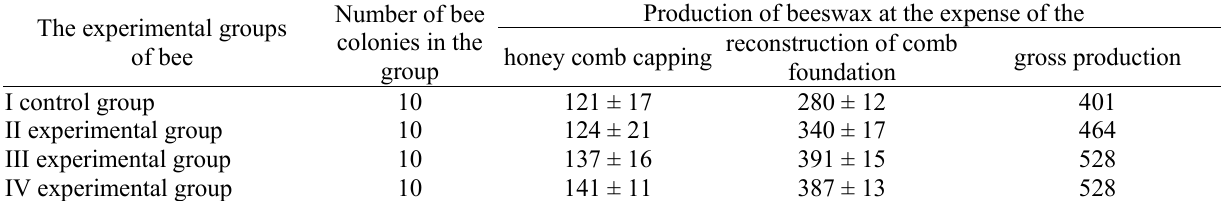
Wax productivity of bee colonies, on average of groups The experimental